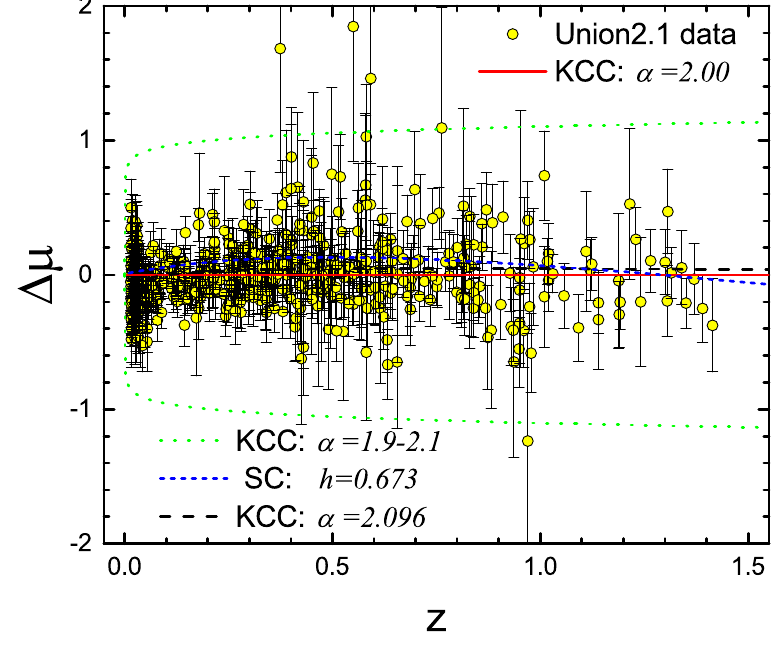
Figure 3. Data from Union 2.1 SNIa set [35] are fitted with Equation (25) and shown as residuals ∆ µ . The baseline is represented by our main KCC fit (red-solid curve, with parameters as in Equation (28)). The meaning of the other curves and symbols is the same as in the previous